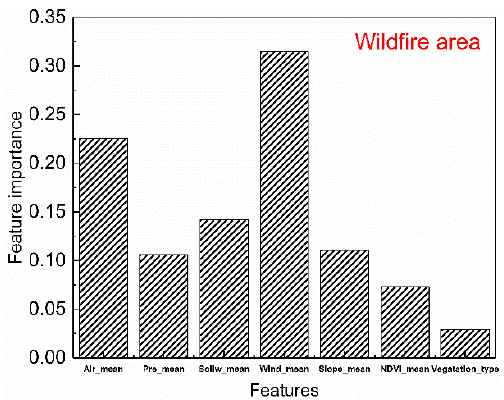
Figure 11. Importance of each driver relative to the area of bushfire spread.